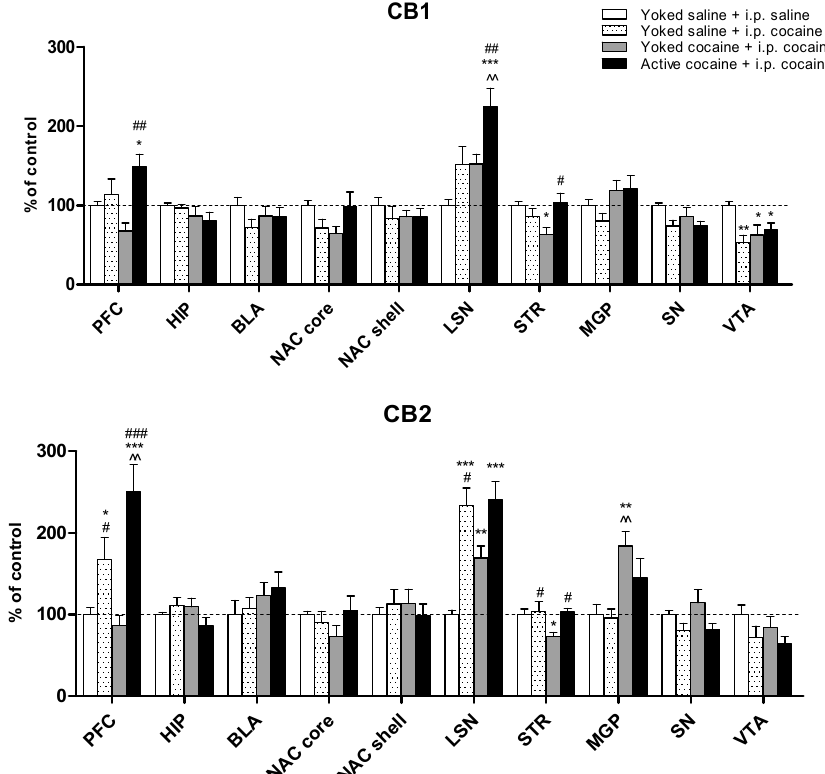
Figure 6. Results of immunohistochemistry analysis of membrane’s cannabinoid receptor 1 and 2 in the reinstatement cocaine phase. All data are expressed as the means ± SEM. N = 7 rats/group. * p < 0.05, ** p < 0.01, *** p < 0.001 vs. Yoked saline + saline i.p.; ˆˆ p < 0.01 vs. Yoked saline + cocaine i.p.; # p < 0.05, ## p < 0.01 ### p < 0.001 vs. Yoked cocaine + cocaine i.p. PFC—prefrontal cortex; HIP – hippocampus, BLA—basolateral and basomedial amygdala, NAC core or shell—nucleus accumbens core or shell, LSN—lateral septal nuclei, STR—dorsal striatum, MGP—medial globus pallidus SN—